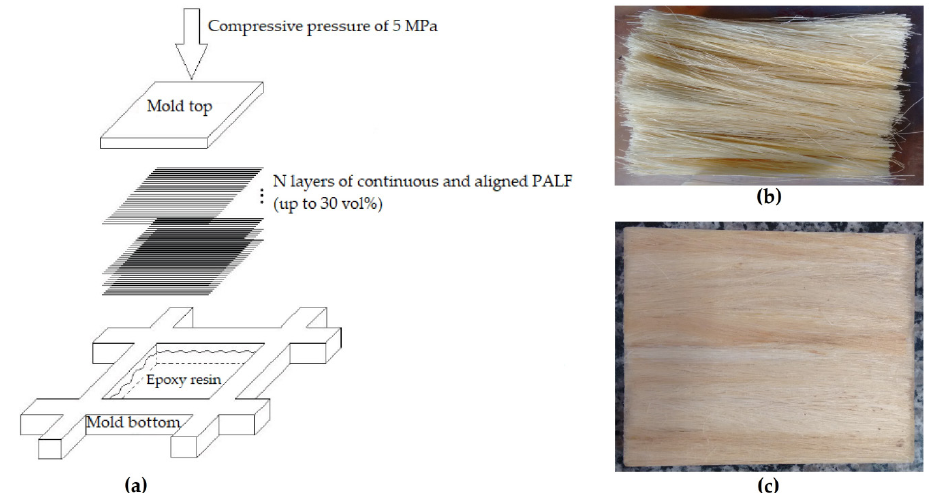
Figure 2. Design and manufacturing of pineapple leaf fiber (PALF) composite: ( a ) hand lay-up process for making composites, ( b ) fibrillated PALF fibers after hand combing, ( c ) 30 vol % PALF / epoxy composite plate (illustration done by the authors).